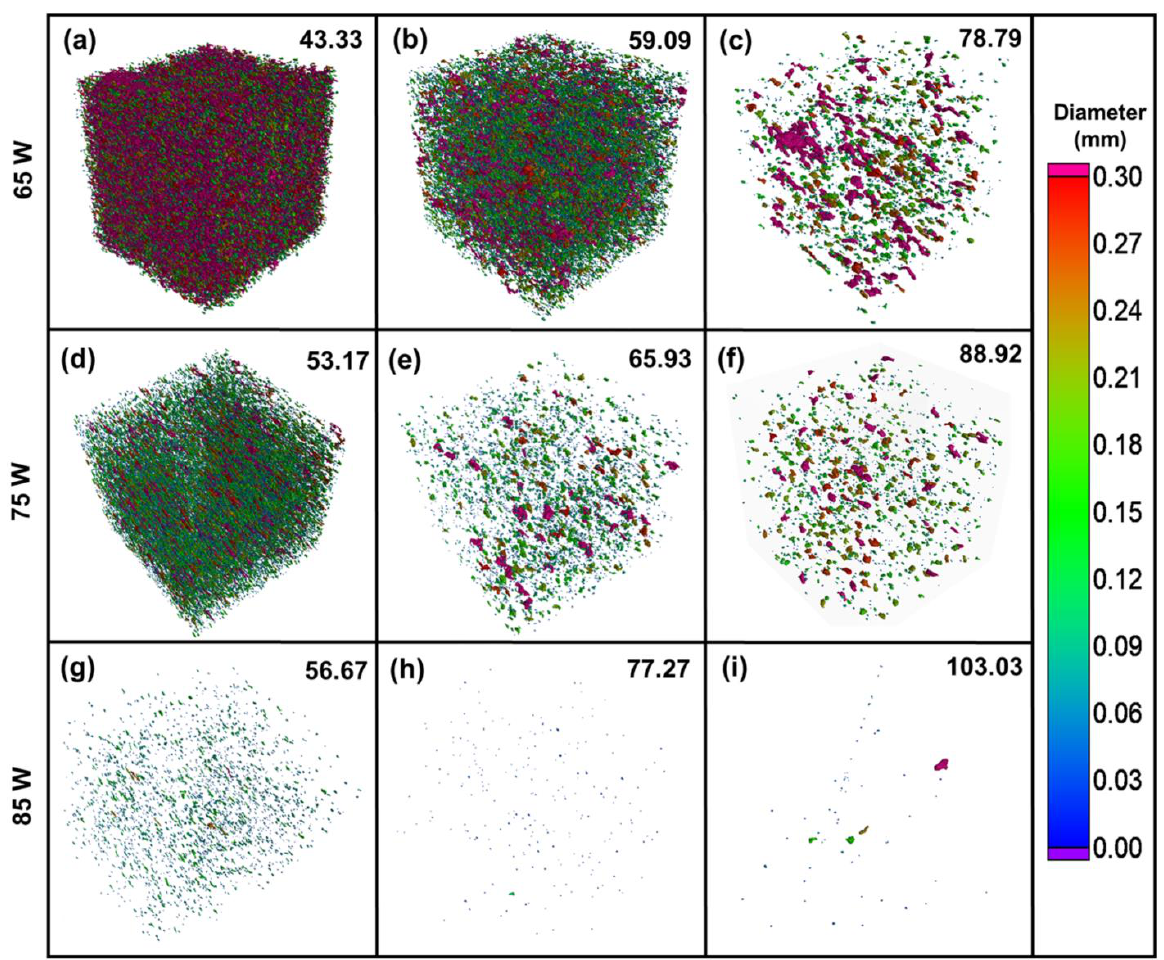
Figure 6. XCT 3D porosity analysis shows number of pores/mm 3 , mean diameter and sphericity change with power: ( a – c ) 65 W, ( d – f ) 75 W, ( g – i ) 85 W, and change with volume energy (denoted in the upper right corner of each image).